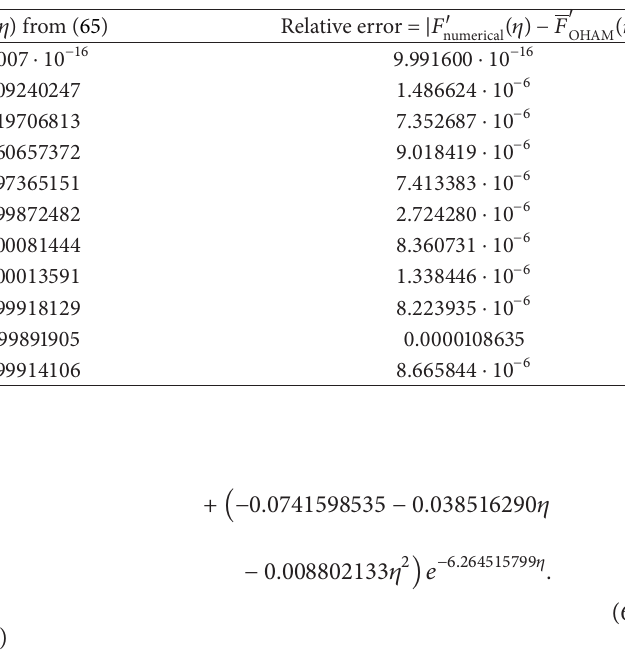
󸀠 (𝜂) obtained from (65) and numerical results for 𝛽 = 1.6